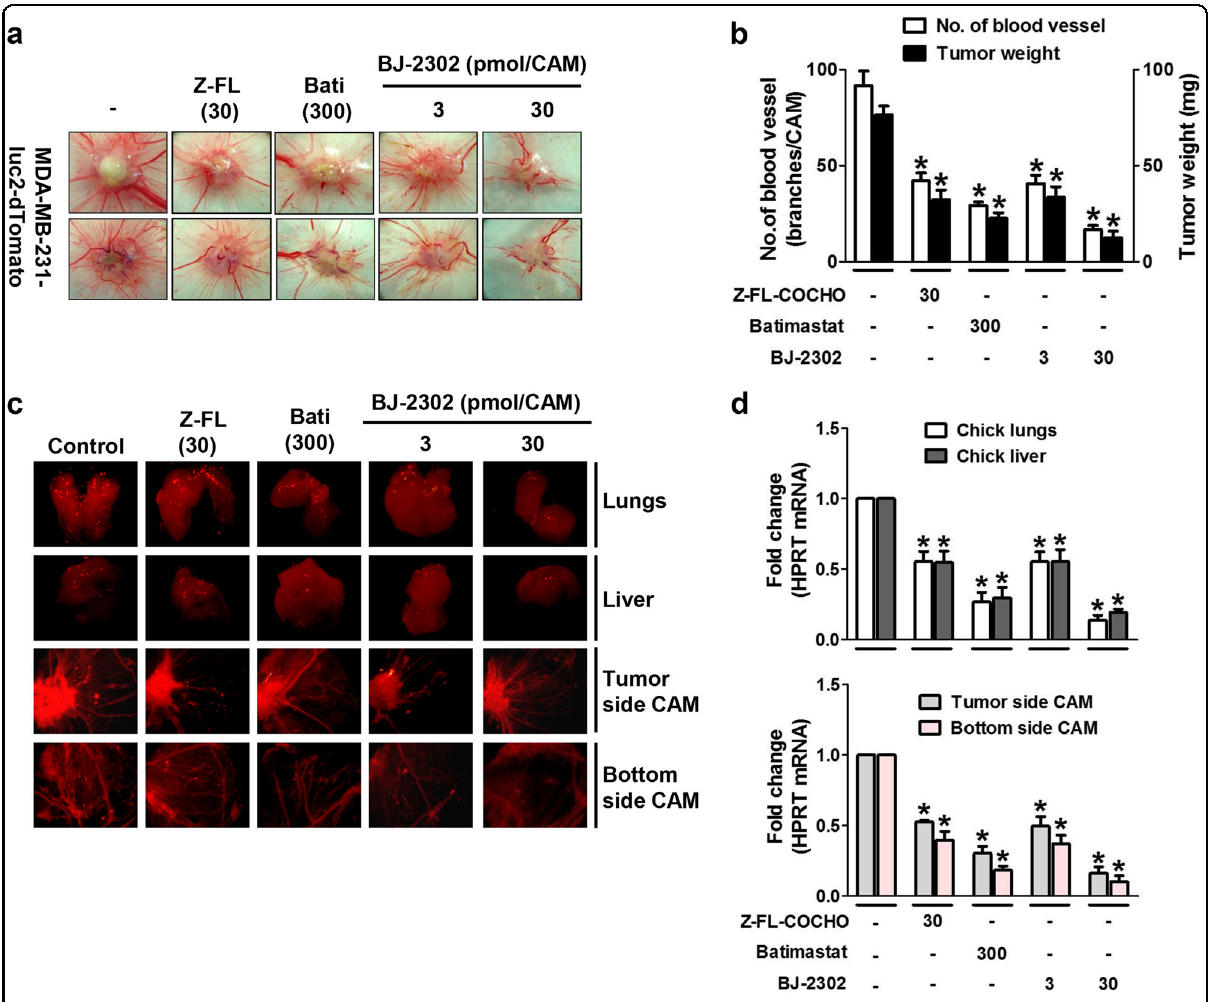
Fig. 4 Anti-metastatic effect of BJ-2302, a non-cytotoxic CTSS inhibitor, in an MDA-MB-231-luc-2-tdTomato cell-xenografted CAM model. MDA-MB-231-luc-2-tdTomato cancer cells were inoculated at the top of the CAM in the presence of indicated drugs. a – d On the 5th day of drug treatment, tumor growth was visualized with images captured under the stereomicroscope ( a ), and the number of blood vessels within the tumor area and tumor weights ( b ) were measured. c , d Images of the developing lungs, liver, lower CAM, and upper CAM were captured for the detection of red- fl uorescence-labeled cancer cells ( c ), and the tissues were examined for HPRT mRNA in the chick lungs and liver (upper bar) and the upper and lower parts of the CAM (lower bar) ( d ). The bar-diagram represents quantitative data. * P < 0.05 compared to vehicle-treated